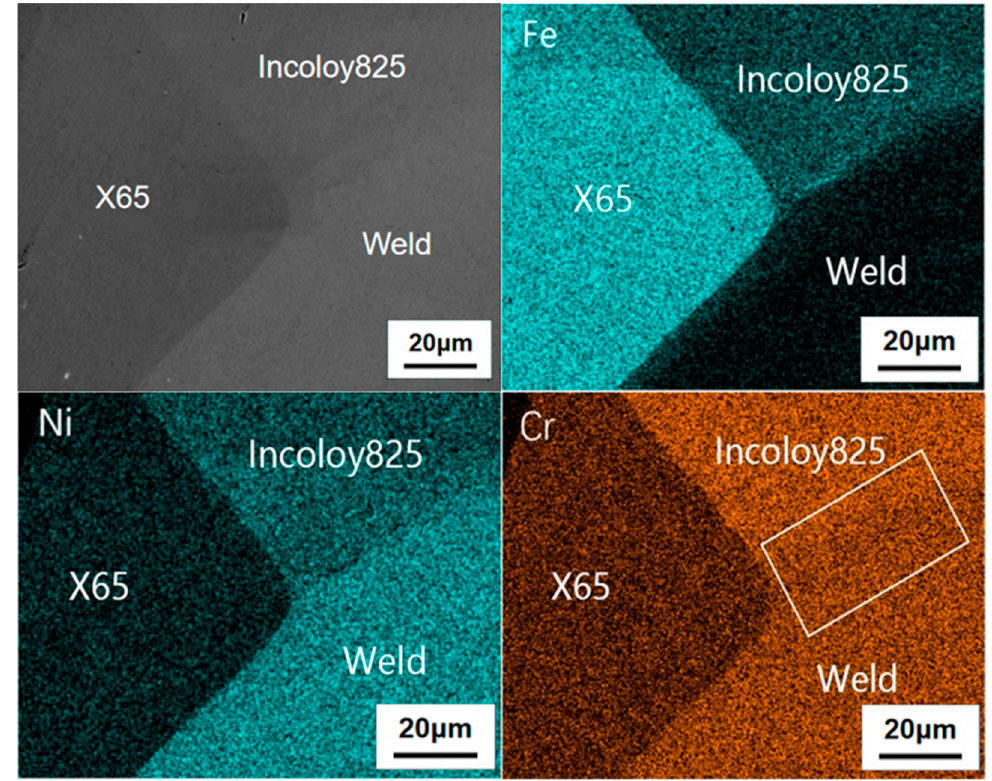
Figure 8. The element surface scanning at the intersection of three zones.